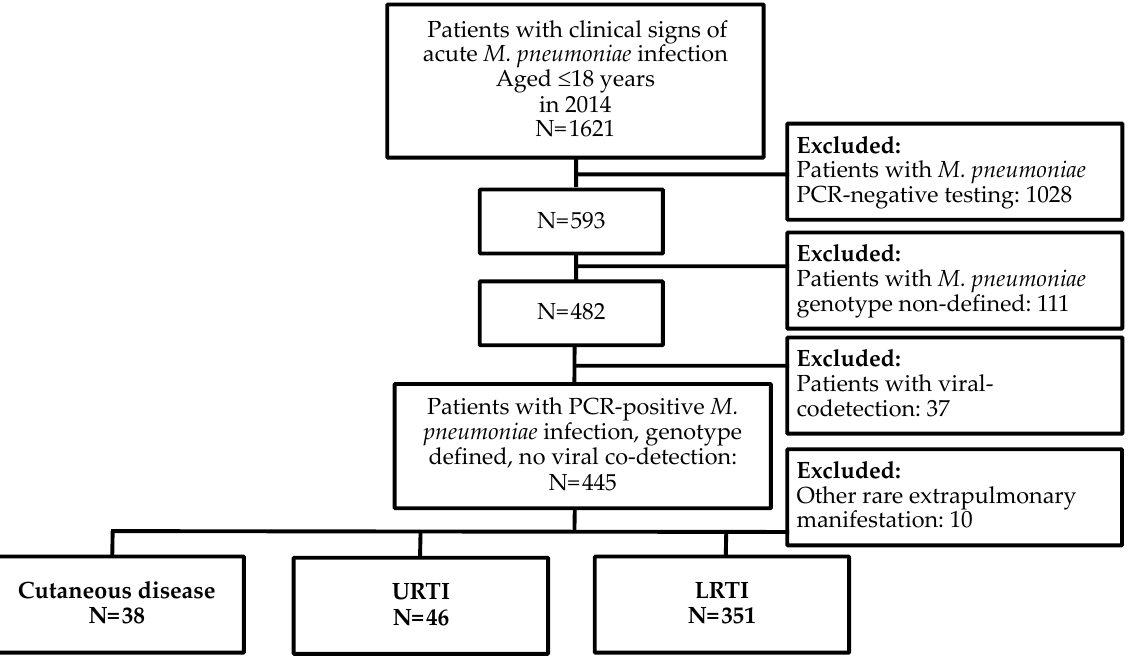
Figure 1. Study flowchart. Abbreviations: LRTI, Lower respiratory tract infection; MLVA, Multilocus variable-number tandem-repeat analysis; URTI, Upper respiratory tract infection.